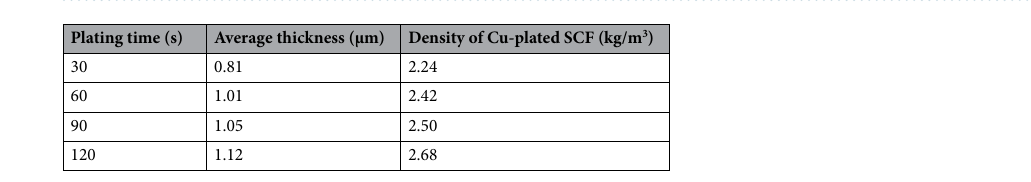
Table 2. Average Cu-plated thickness and density of Cu-plated SCF by different plating times.